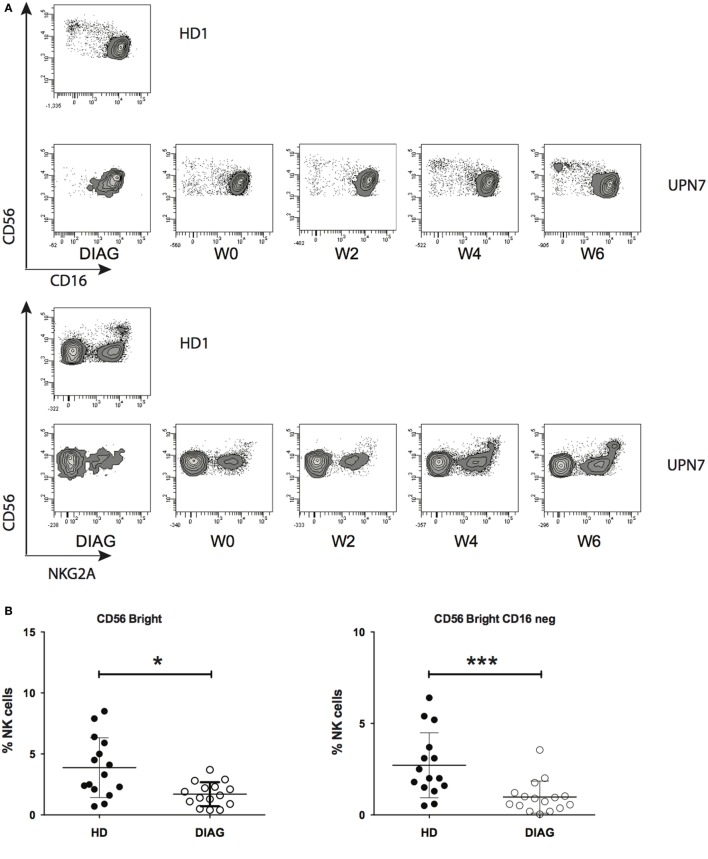
Kinetics of immature NK cells reconstitution. (A) Example of reconstitution of CD56bright NK cells in a patient following treatment. The figure displays the reapparition of CD56bright NK cells expressing or not CD16 (top) or NKG2A (bottom). (B) Frequencies of total CD56bright NK cells (left panel) or CD56bright NK cells lacking CD16 expression (right panel). (C) Summary figure of reconstitution of the immature CD56bright NK cell subset after induction and consolidation therapies. Data represent Tukey whisker boxes, with outliers represented as round dots. When indicated a Kruskal–Wallis non-parametric test with Dunn’s posttest was performed to compute the P value for the comparisons (*P < 0.05, **P < 0.01, ***P < 0.001).